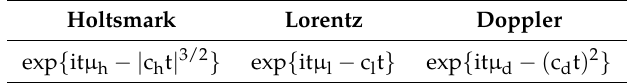
Table A2. Characteristic functions, ϕ ( x ) for one-dimensional Holtsmark, Lorentz, and Doppler profiles.